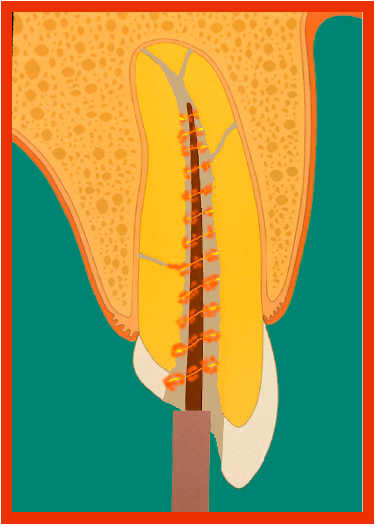
Figure 1. The image illustrates the novel Endo tip (in dark brown color) inside a root canal, where the propagation of the laser energy is all along the canal, including the lateral walls. The image was kindly obtained by Prof. Adam Stabholz at our Faculty.